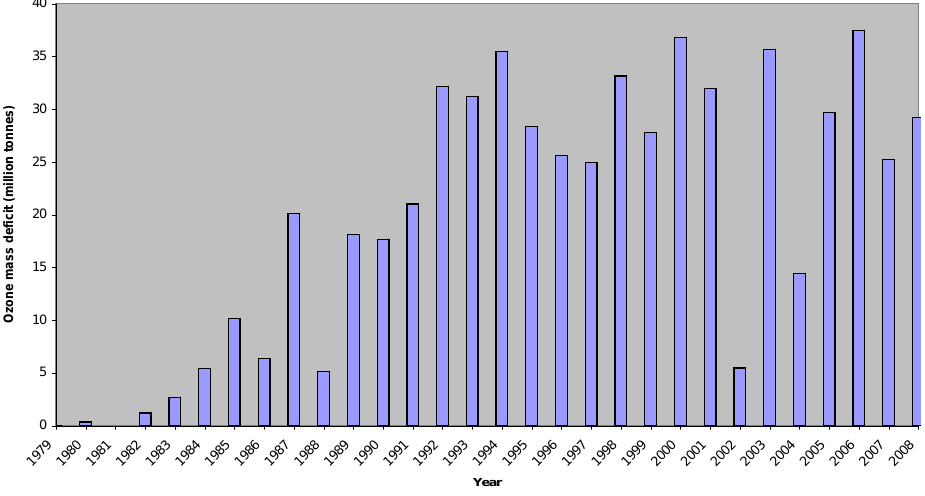
Fig. 4. The ozone mass deficit over Antarctica in the period 21–30 September based on the multi-sensor re-analysis (MSR) total ozone in the period